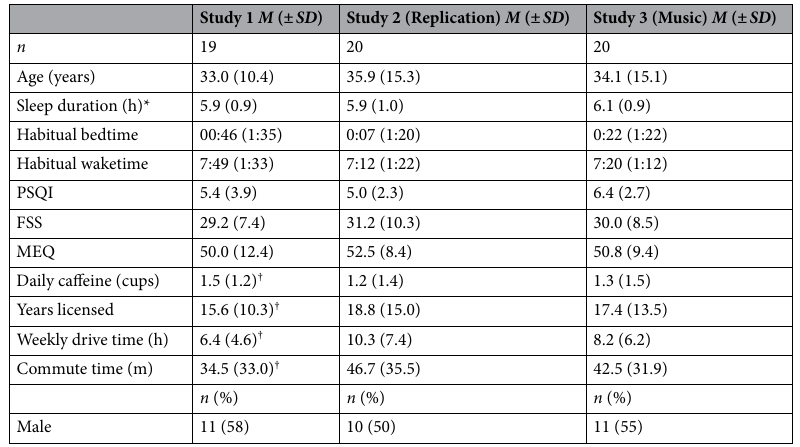
Table 1. Participant demographics. *As measured by actigraphy during the two weeks prior to the study; † n = 13 for these questions, as a questionnaire with these items was sent retrospectively to participants in Study 1; Commute time = one way; PSQI = Pittsburgh Sleep Quality Index; FSS = Fatigue Severity Score; MEQ = Morningness-Eveningness Questionnaire; h = hours; m = minutes; M = mean; SD = standard